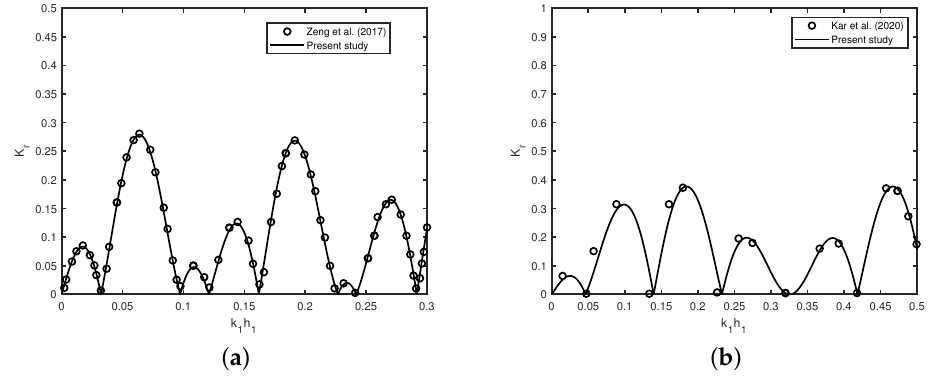
Figure 2. Variation of reflection coefficient K r versus wave number k 1 h 1 for ( a ) double breakwaters and ( b ) double trenches in the absence of friction C f = 0. Here, ◦ indicates Zeng et al. [35] and − specifies Kar et al.